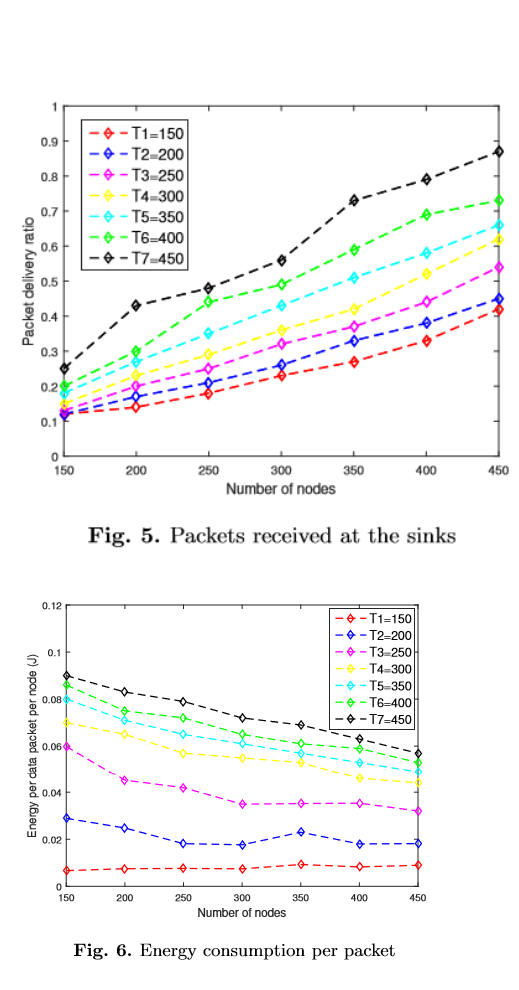
Scenario II: Fig. 5 shows the impact of different transmission levels on the PDR. Transmission